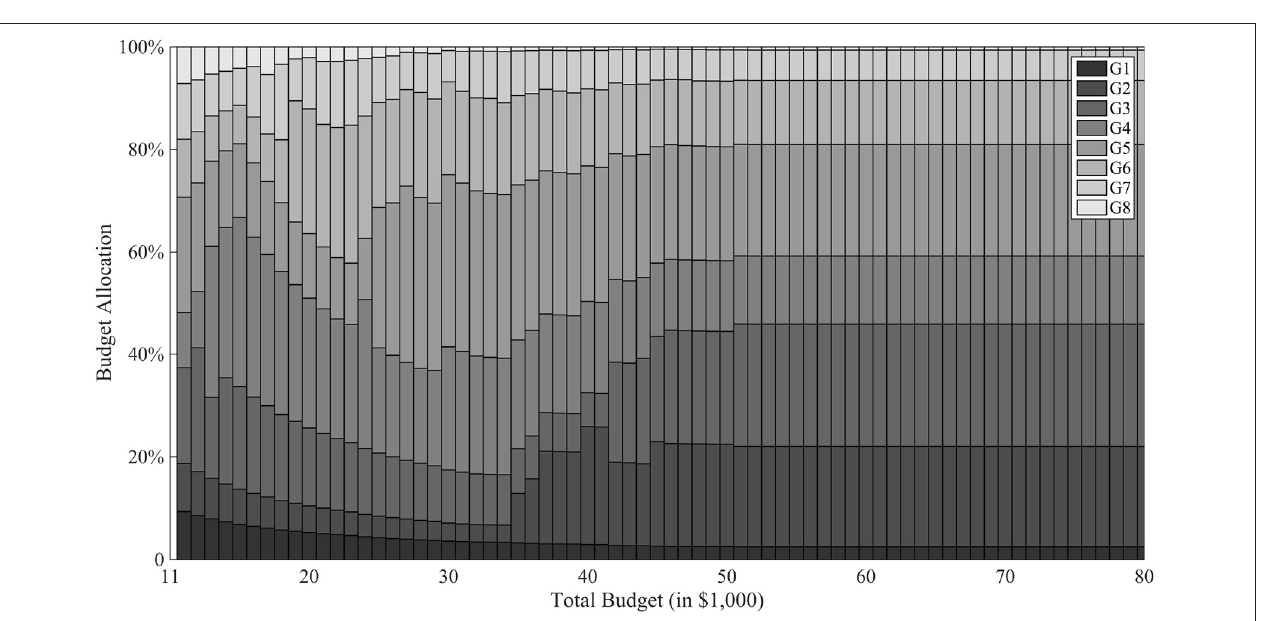
focuses on dynamic balance of both budget and time